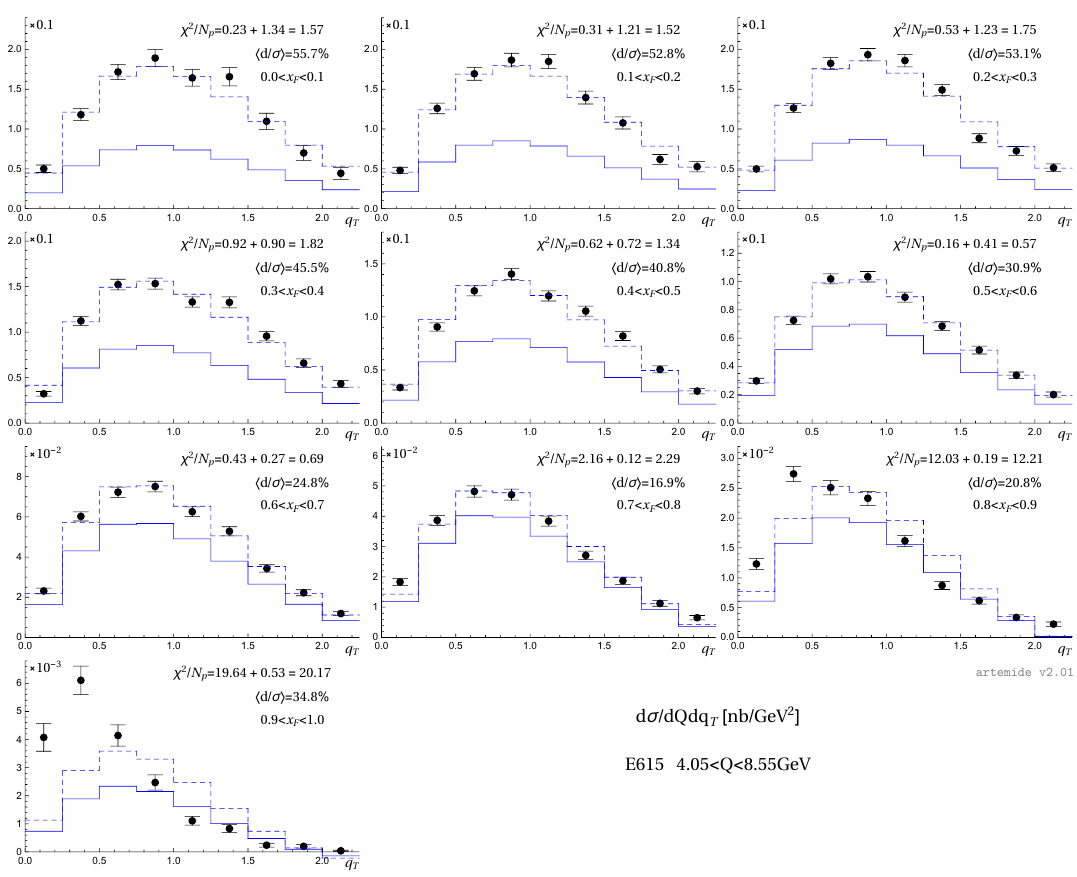
Figure 3 . Comparison of the theory prediction (solid line) to E615 di(cid:11)erential in x F . The dashed line is the theoretical prediction after the addition of systematic shifts d i . The values of the (cid:31) 2 and d i are calculated for the each x F -bin with 16% correlated